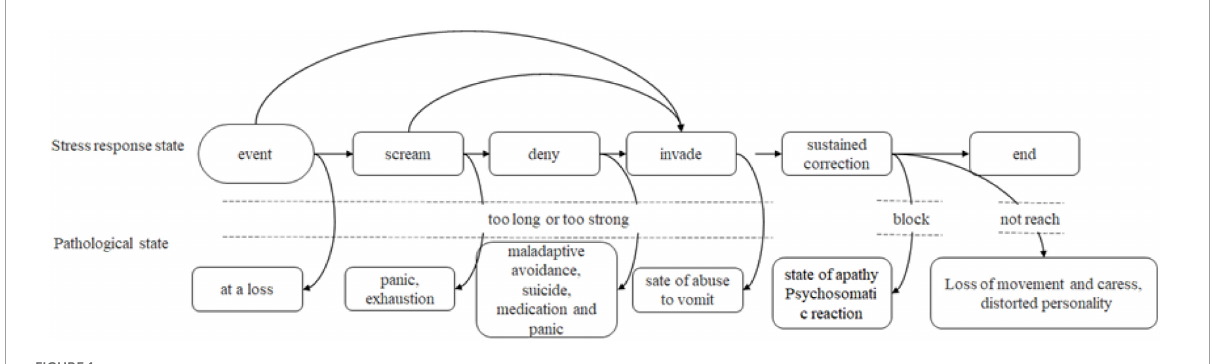
FIGURE1 Stress response process model.